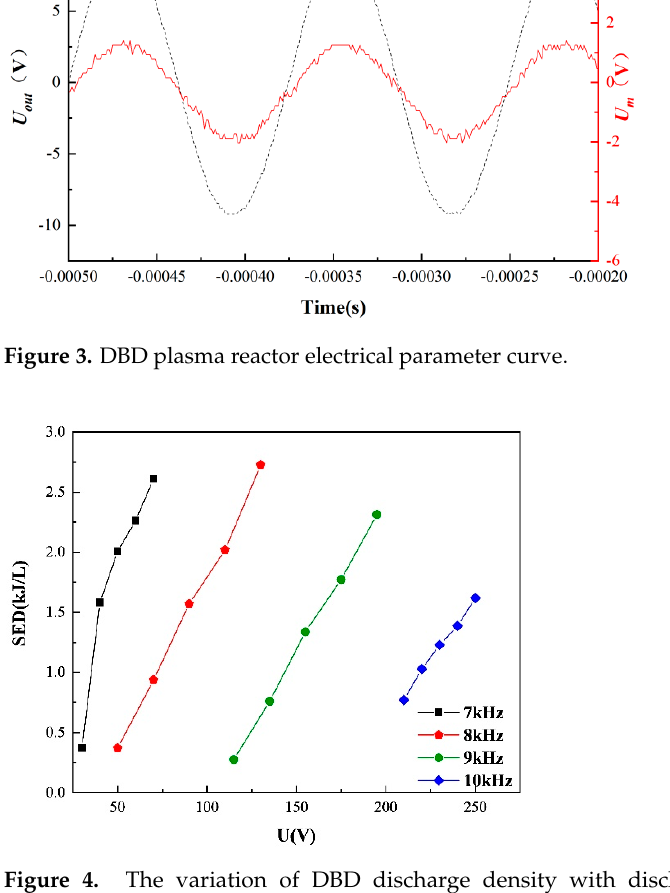
Figure 5. The influence of discharge frequency on NOx removal efficiency at different SEDs: ( a ) NO removal efficiency; ( b ) NOx removal efficiency. When the discharge frequency exceeds 8 kHz, as the frequency increases, a larger discharge power and energy density are required to obtain the same NOx removal effi- ciency, which will cause the temperature of the discharge area to rise. The main chemical reactions for NOx removal in the DBD reactor are shown in Formulas (3)–(10), where the reaction rate of Reaction (9) is much smaller than that of Reaction (10). The increase in power frequency will increase the collision rate of active particles with NO, thereby accel- erating the reaction rate of Reactions (7) and (9). However, the Reaction (3) is an exother- mic reaction and the rise of temperature in the discharge region will shift the balance of the reversible reaction to the left [22], so that there is not enough O 3 for Reaction (10). The discharge frequency is not the only factor that affects the NOx removal efficiency. In this case, as the power frequency increases, more energy is consumed on the high-voltage electrode of the DBD. As a result, the reactor temperature is increased and Reaction (3) accelerates to the left, so that the reaction rate of Reaction (10) as well as the NOx removal efficiency are reduced [23]. Therefore, when the discharge frequency is greater than 8 kHz, the NOx removal efficiency is reduced as the discharge frequency increases. Since the maximum regulated voltage of the plasma power supply is 250 V, the reaction is ended